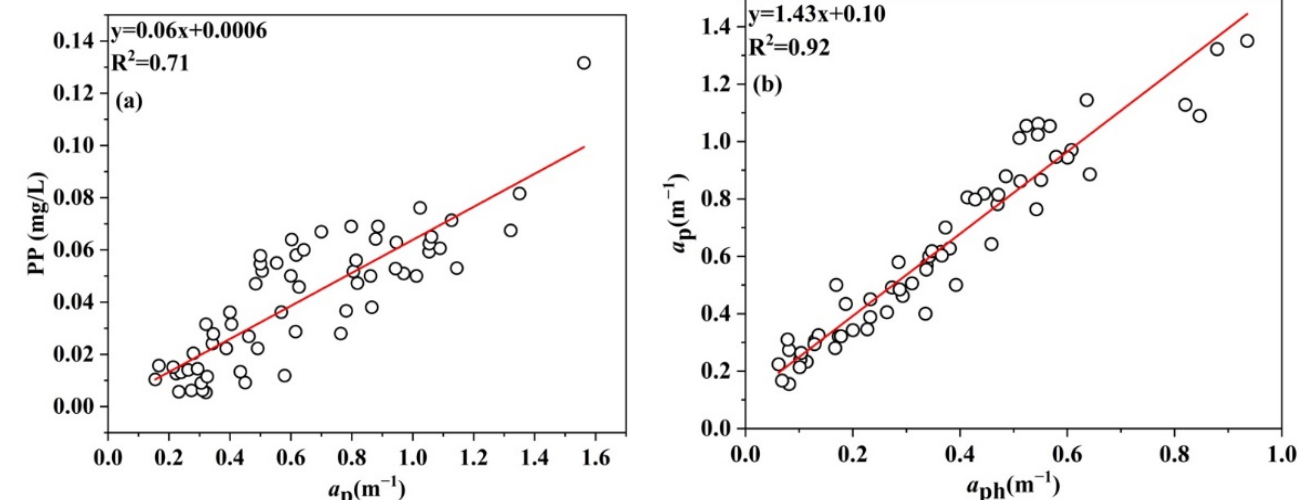
Figure 3. ( a ) The TP concentration and a p fitting curve at 677 nm; ( b ) the a ph and a p fitting curve at 677 nm.